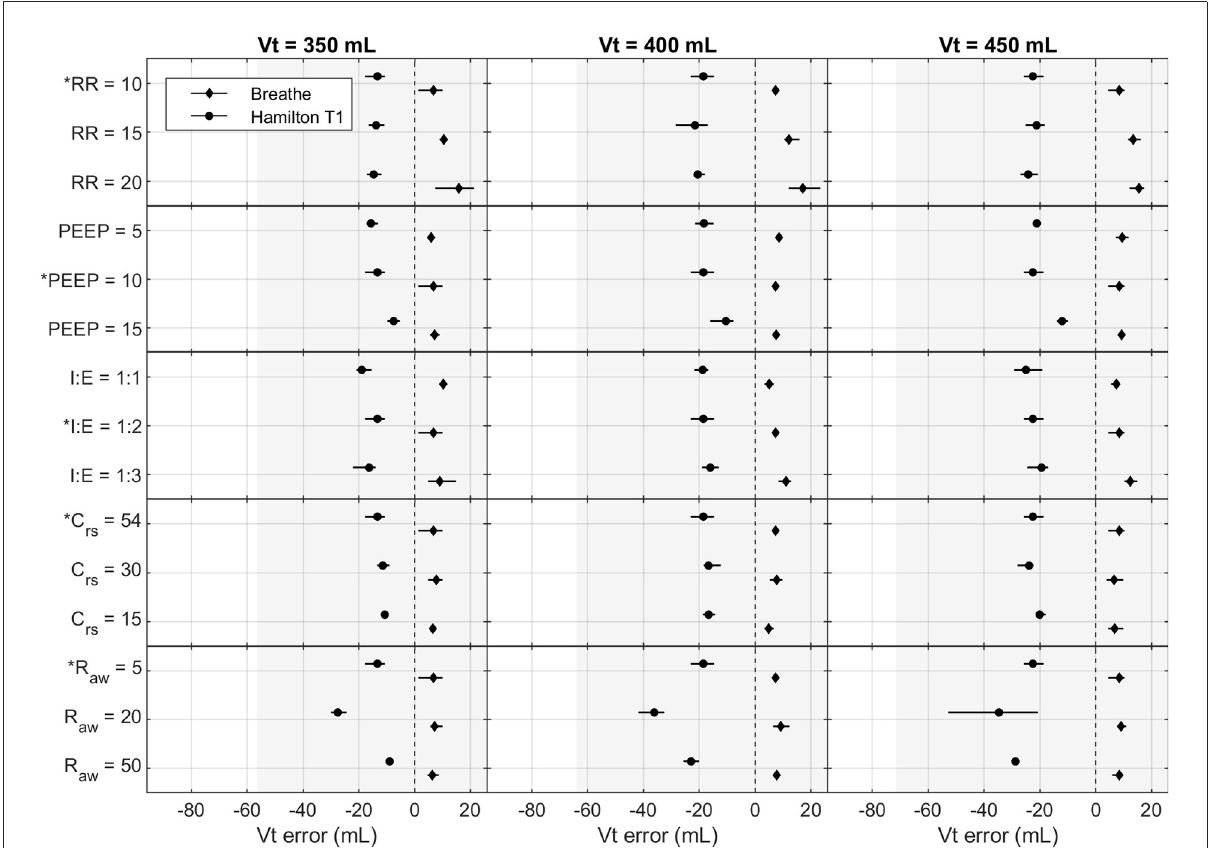
FIGURE5 Measured Vt error in the Hamilton T1 ((S)CMV + mode) and the breathe: effects of altering Vt (mL), RR (bpm), PEEP (cmH 2 O), I:E (ratio), Crs (mL cmH 2 O − 1 ), and Raw (cmH 2 O s L − 1 ). The base setting is indicated by * . The markers and lines denote the mean error and the maximum and minimum errors, respectively. The grayed-out area indicates the acceptable performance tolerance according to the ISO 80601-2-12 norm and the MHRA